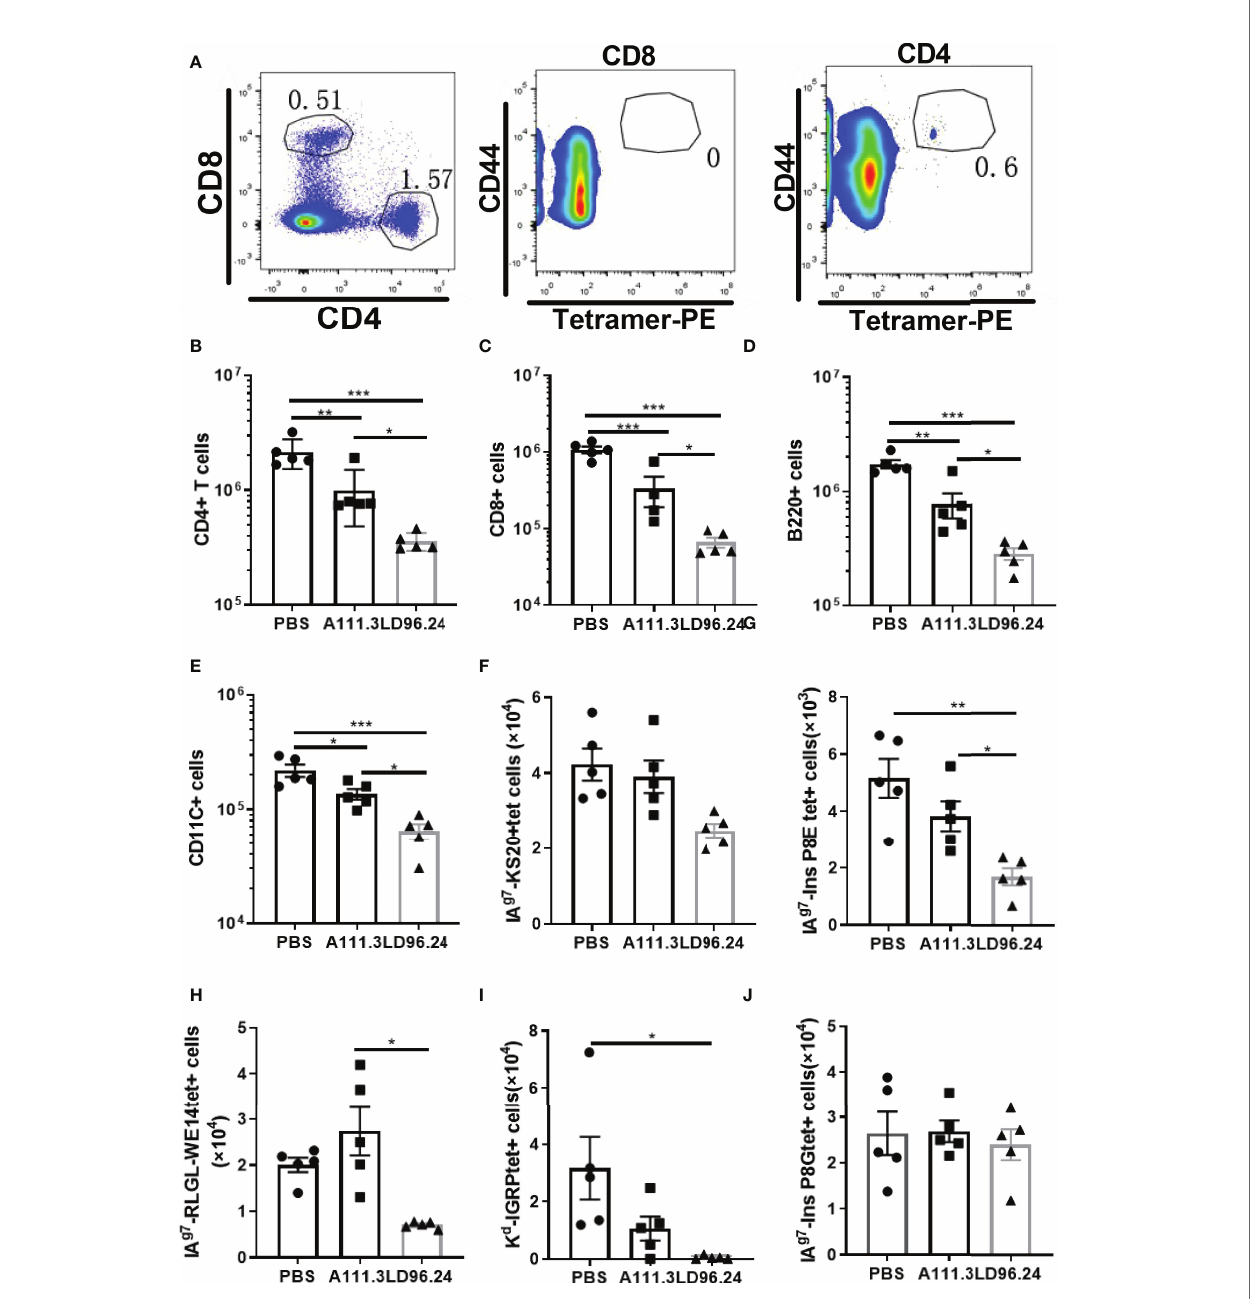
FIGURE 5 | The impact of LD96.24 on lymphocyte changes in the pancreas. Three groups (5 NOD mice/group) were treated weekly from age 4 weeks with PBS, 0.5 mg A111.3 or LD96.24, and pancreatic cells were isolated at age 10 weeks. (A) Representative scatter diagram of the gating strategy for tetramer-positive CD4 + T cells. First gating on live, B220-, F4/80-, CD8-, CD44high, and CD4 + T cells, then using CD8+ T cells to set gate to examine the tetramer-positive CD4 + T cells. (B – D) The average number of CD4 + T cells (B) , CD8 T cells (C) , B cells (D) , and DCs (E) in the pancreas. (F – J) In fi ltrated tetramer-positive CD4 + T cells and CD8 T cells, including IAPP KS20-reactive T cells (F) , InsP8E-reactive T cells (G) , RLGL-WE14-reactive T cells (H) , Kd-IGRP-reactive T cells (I) , and InsP8G-reactive T cells (J) in the pancreas were detected with fl ow cytometry. Data are the means ± SEM of each group. Statistical analysis was performed using one-way ANOVA with Tukey ’ s multiple comparison test. *P < 0.05, ** P < 0.001, *** P <